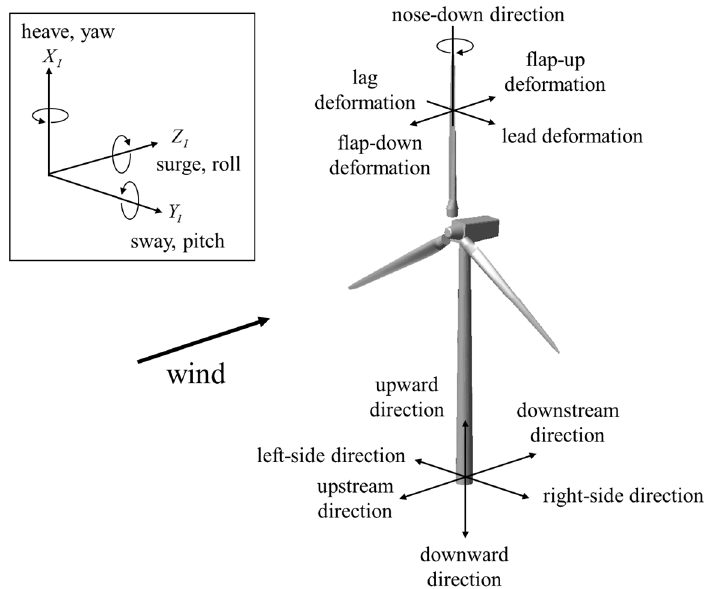
Figure 7. Definition of platform motions and blade deformations.